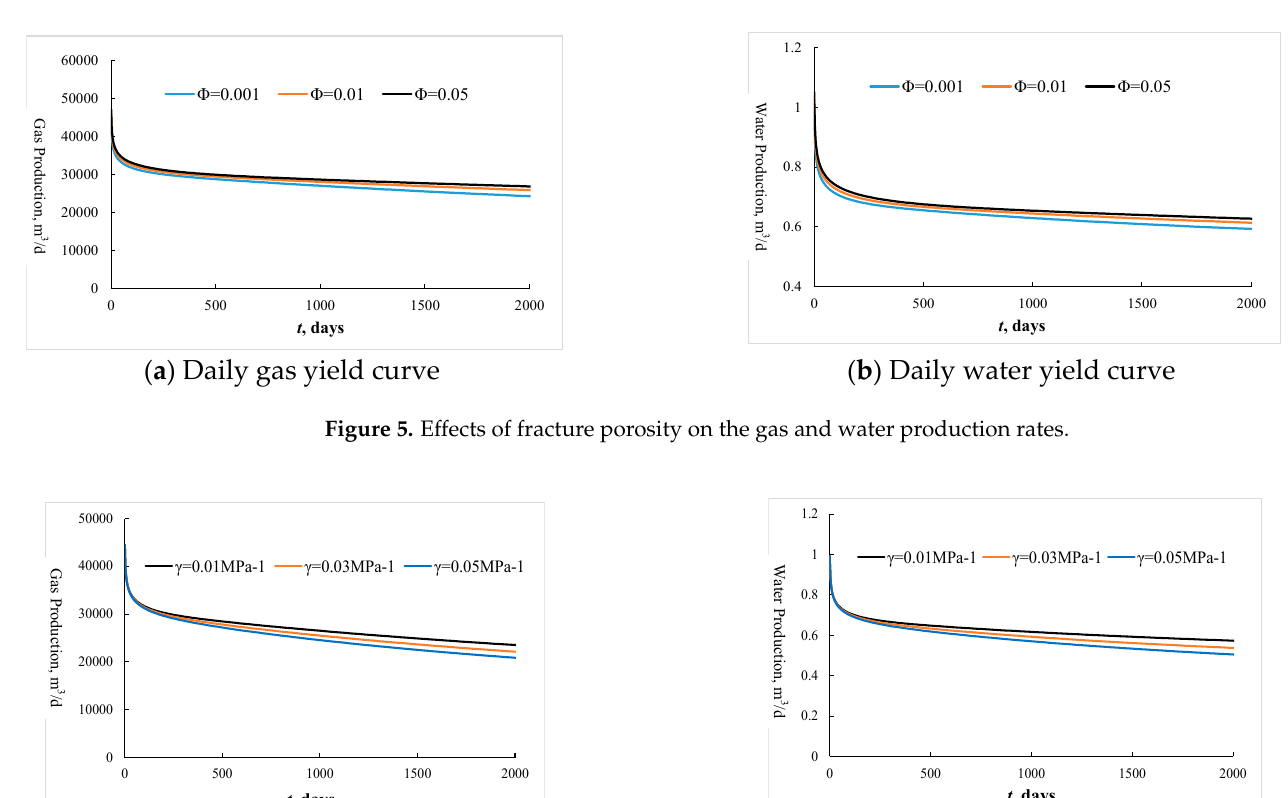
water production curve, and the faster the production decline. In addition, the distance from the outer